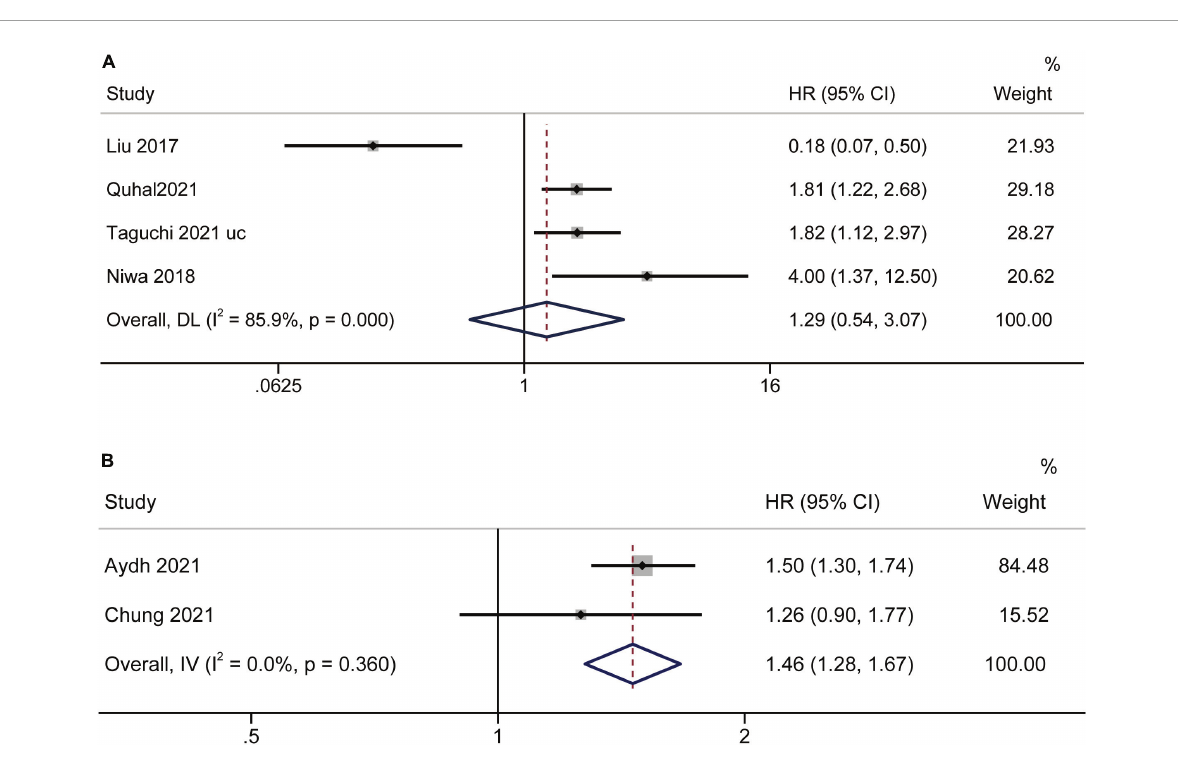
FIGURE7 Forest plot reflects the association between AGR and PFS/BRFS for urological cancers. (A) AGR and PFS; (B) AGR and